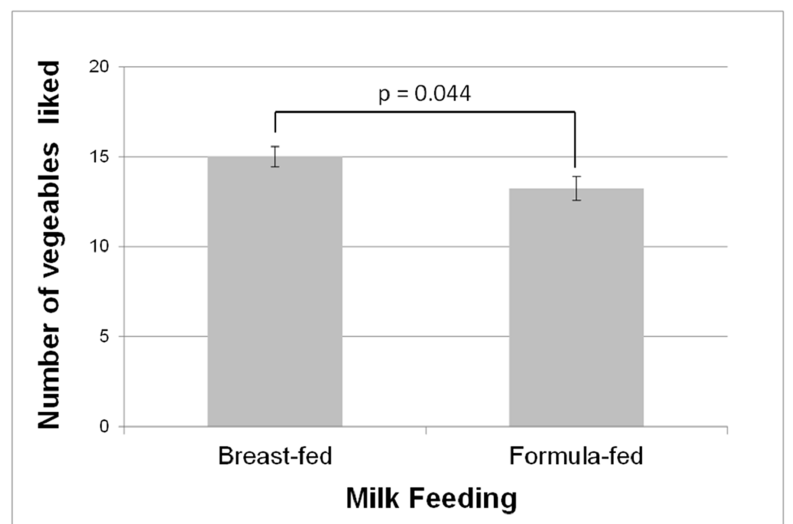
Fig 2. Higher number of vegetables liked by 15-month old children if they had been breast-fed. Mean ± SE of the maternal reports of number of vegetables eaten and liked at follow-up 1.